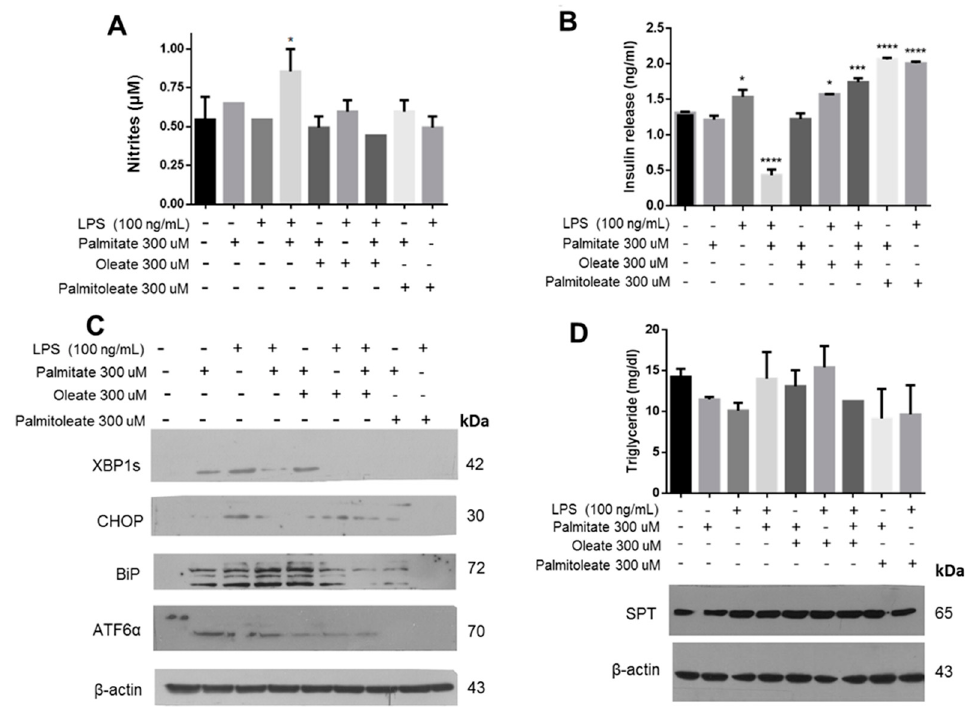
Figure 6. Unsaturated fatty acids could regulate the insulin secretion. ( A ) Quantification of nitrites in the extracellular medium under the incubation with several fatty acids and LPS. ( B ) Insulin secretion in cells exposed to the same treatments. ( C ) Western blot of UPR targets, XBP1s, CHOP, BiP and ATF6 α . ( D ) E ff ect of treatments on metabolic regulation through intracellular quantification of triglycerides and evaluation of SPT. β -actin was used as a loading control. In panels ( A ) and ( B ), ( n = 3, mean ± SD), * p < 0.05, *** p < 0.01, **** p < 0.001 compared to